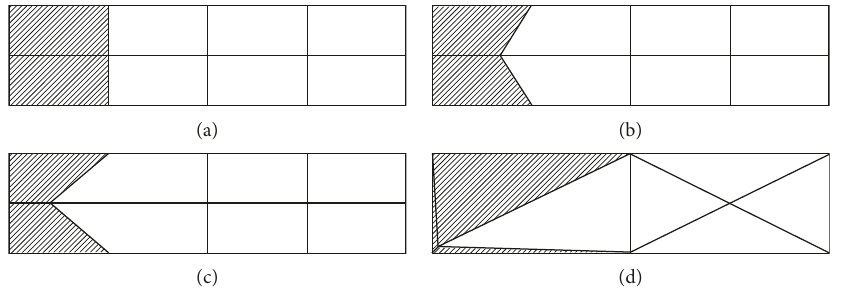
Figure 12: FE meshes used for the study of mesh irregularity (after the study [56]): (a) Mesh A; (b) Mesh B; (c) Mesh C; (d) Mesh